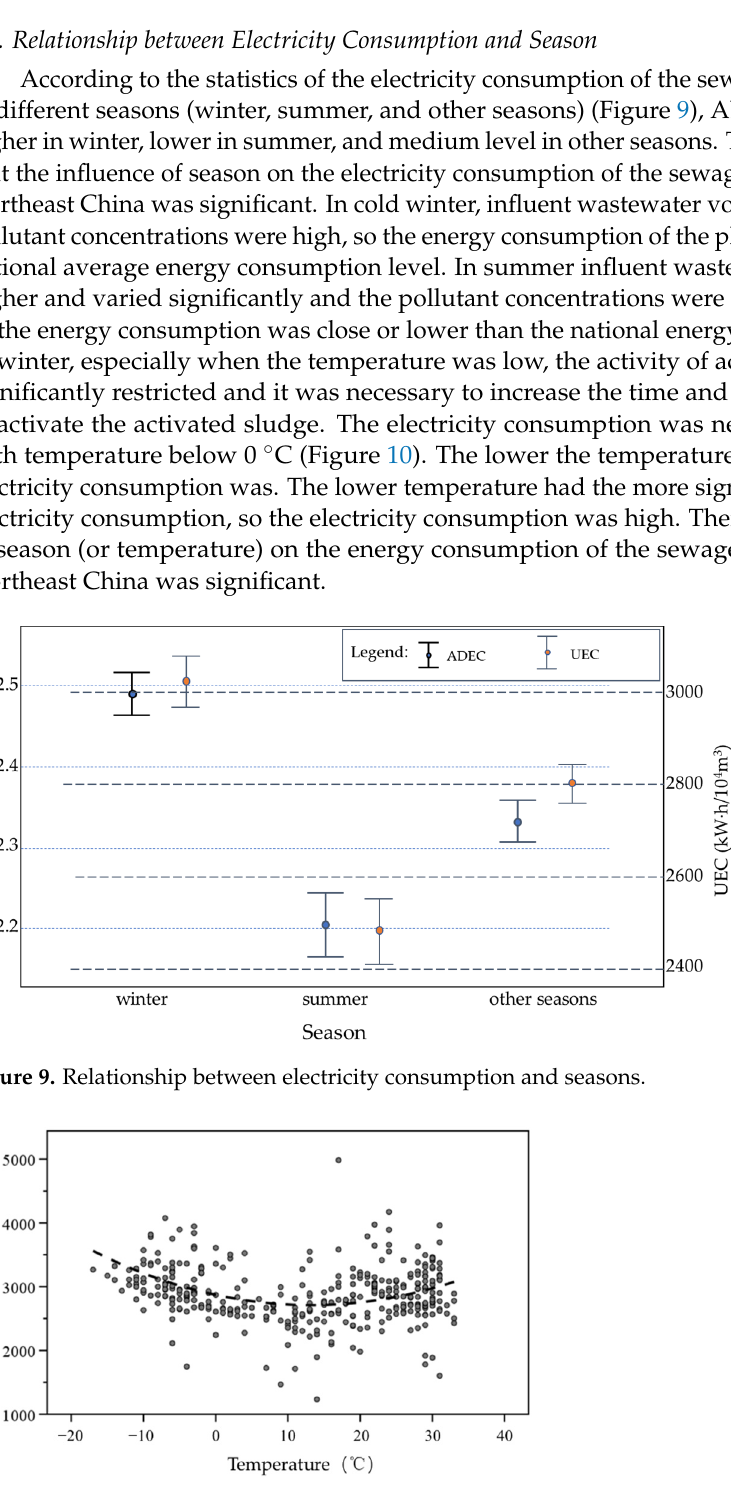
Figure 10. Regression diagram of temperature and electricity consumption per unit of wastewater.